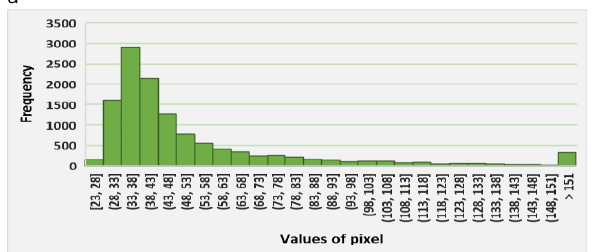
Figure 6. Histogram of water pixels from SAR data Here, the histogram has peak values between 33 and 38. The mean of these values are selected as a parameter for fuzzy b: 0,003 to maximize the membership in Equation 2. Figure 7, shows the result of the clustering having two classes which are land and water. The centroid method is chosen to cluster the pixels as land pixels and the rest of water (Figure 8a). The boundary of the water class is generated as the shoreline. Then, the classified SAR image is converted raster to vector form.